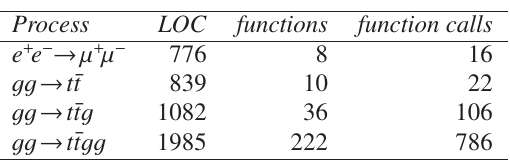
Table 1. Comparison of the complexity of generated CUDA code for various physics processes, as the number of relevant Feynman diagrams increases. The columns represent the number of auto-generated lines ( LOC ), the number of individual generated functions ( functions ) and the number of function calls during one calculation ( function calls ), as several functions are called multiple times with di ff erent parameters. An additional source of complexity, not shown in this table or in Fig. 3, is the size of the color matrix required by the QCD color flow algebra, described in Sec. 2.